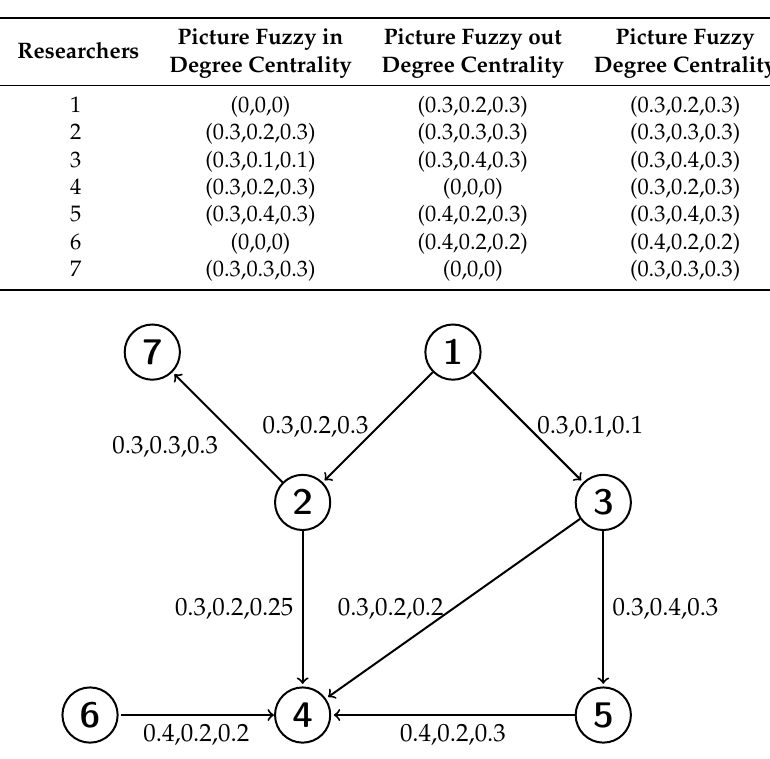
Table 1. The picture fuzzy degree centrality of research team.